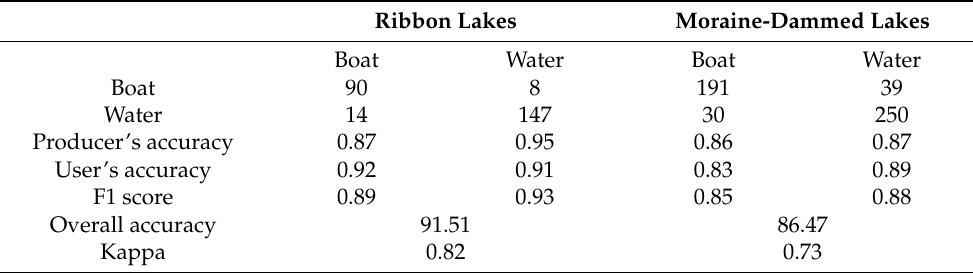
Table 3. Recreational boat classification confusion matrix for ribbon and moraine-dammed